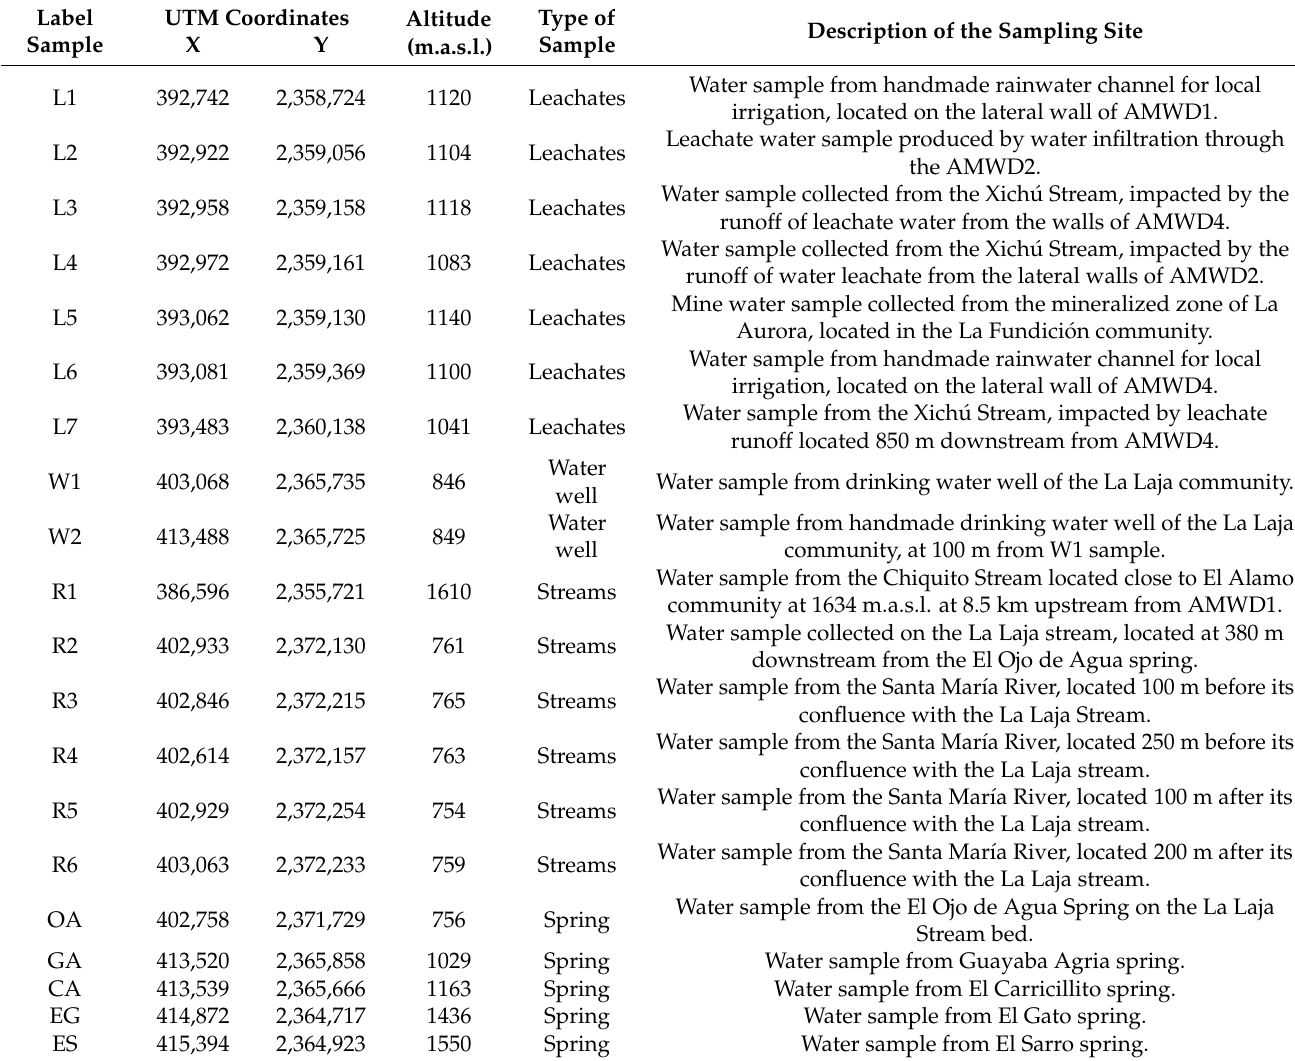
Table 1. Geographical location, type, and physical condition of the aqueous and solid samples collected in the study area. Label